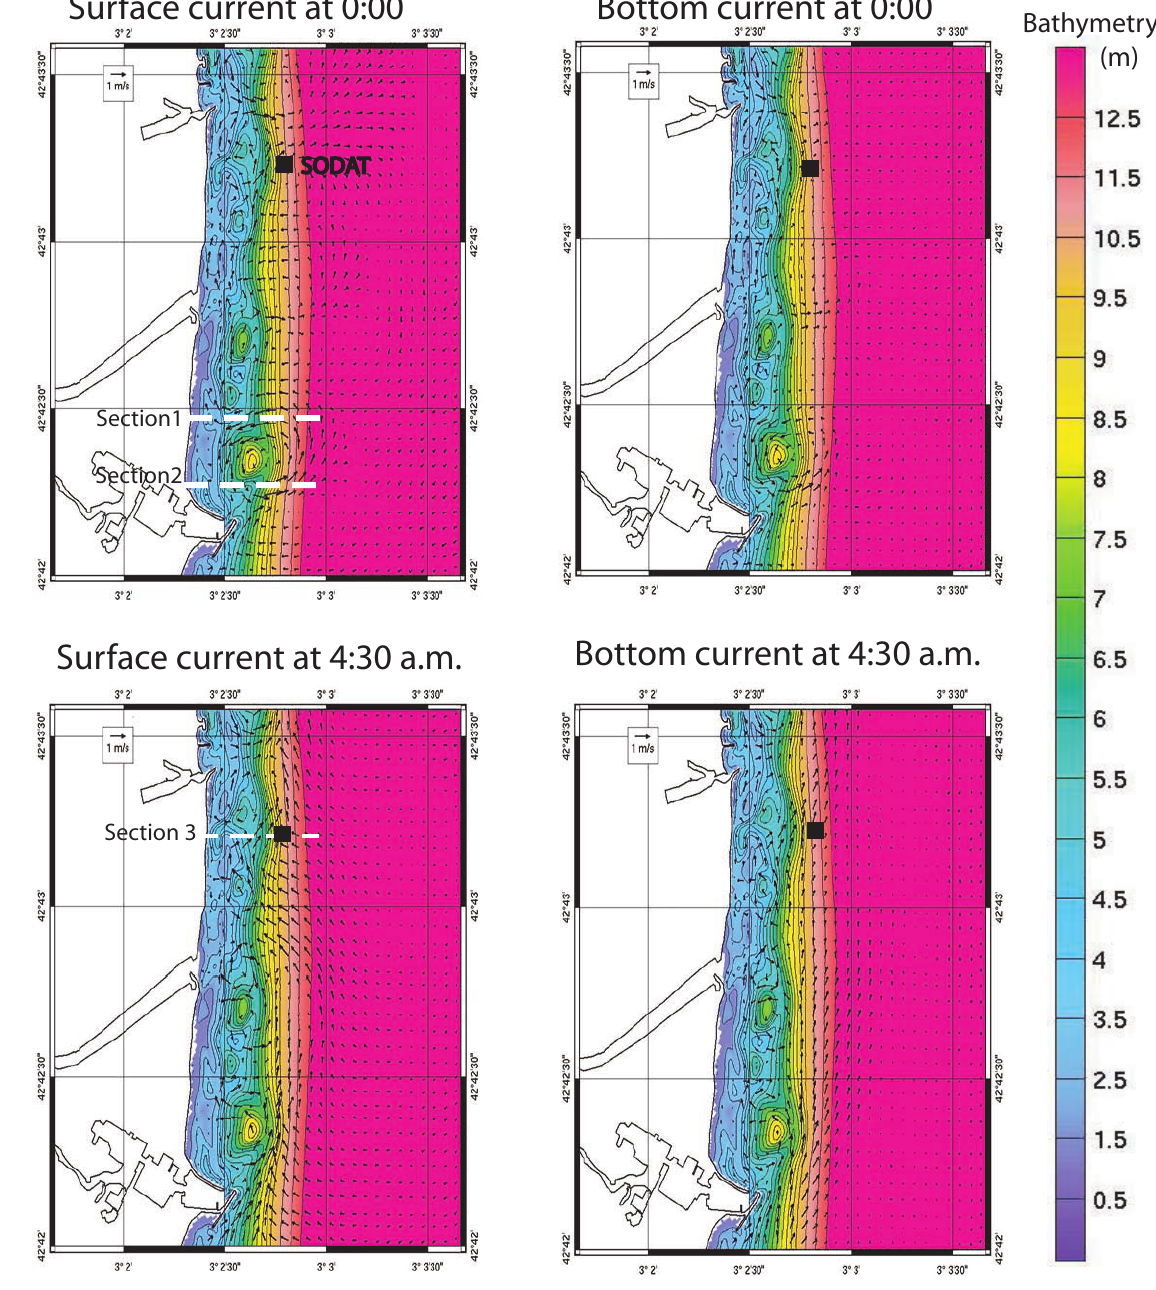
Fig. 15. Two different current patterns at an interval of 4.5h: – Surface and bottom current on 21 February at 0:00 a.m. during the rising stage of the storm – Surface and bottom current on 21 February at 4:30 a.m. at the storm apex The color palette indicates the bathymetry, whereas the arrows are the current vector. Position of the SODAT instrument is indicated with the black spot, as well as the position of the cross-shore sections of the following figure. Surface current is at 1m of water depth under the sea surface and bottom current is at 1m above the bottom. Circulations in the surf zone are mainly driven by the Bernoulli head, wave breaking dissipation forces and also pressure gradient. Theses forces have similar orders of